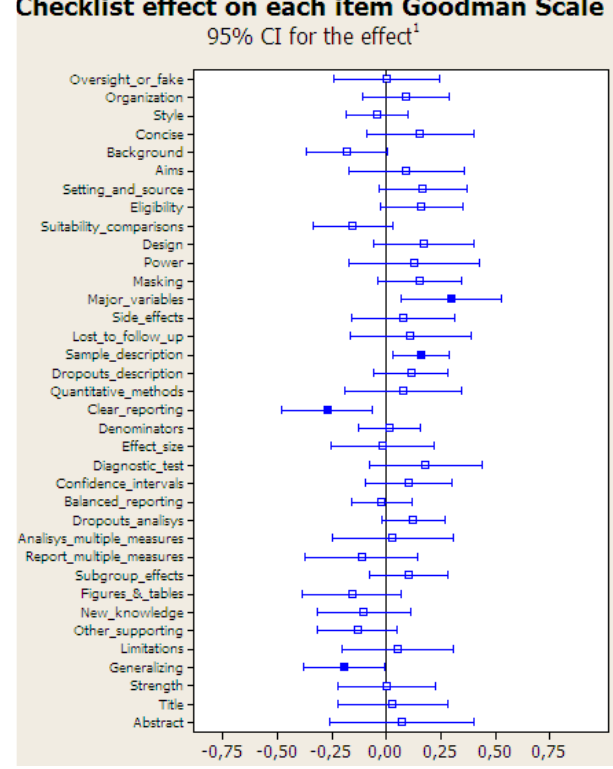
Figure 5. Estimated effect of checklist suggestion on the 36 Goodman items. Solid boxes indicate statistically significant effects. 1 Differences in improvement from baseline between groups with and without checklist suggestion